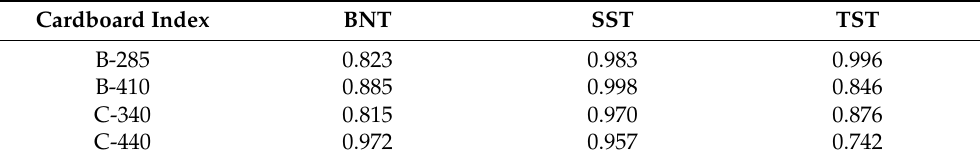
Figure 14. The decreases in measured values (average from two directions) for corrugated board with an index: ( a ) B ‐ 285; ( b ) B ‐ 410; ( c ) C ‐ 340 and ( d ) C ‐ 440. Table 4. The coefficient of determination 𝑅 (cid:2870) between crushing and average normalized values. Table 4. The coefficient of determination R 2 between crushing and average normalized values.